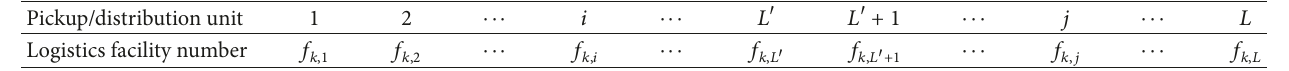
Table 1: Two-dimensional chromosome encoding